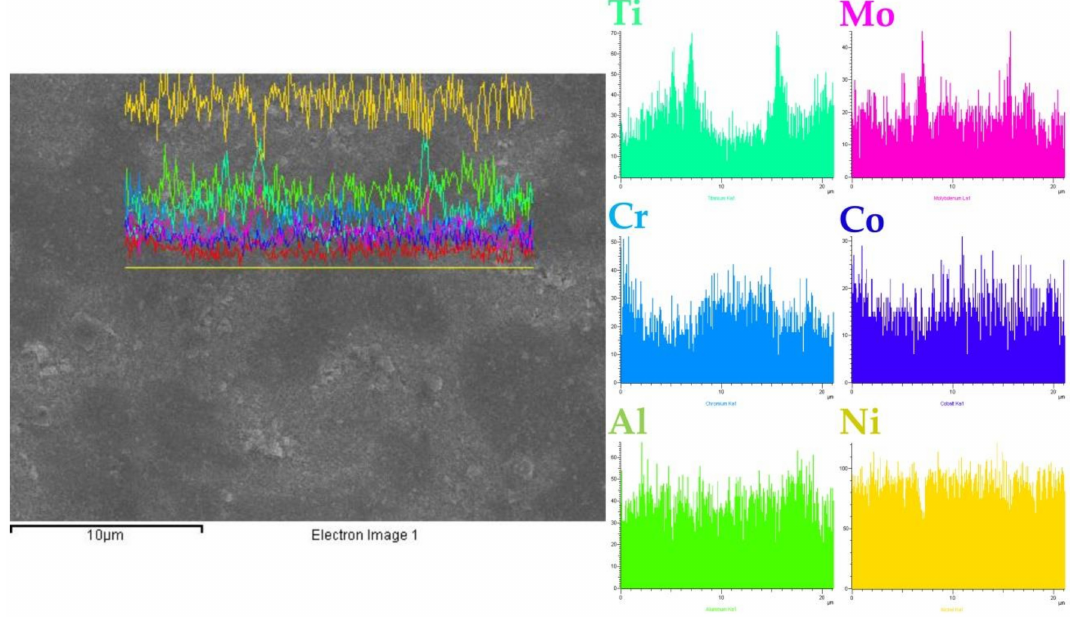
Figure 3. Energy dispersive spectrometer (EDS) results of line scanning on the X–Y